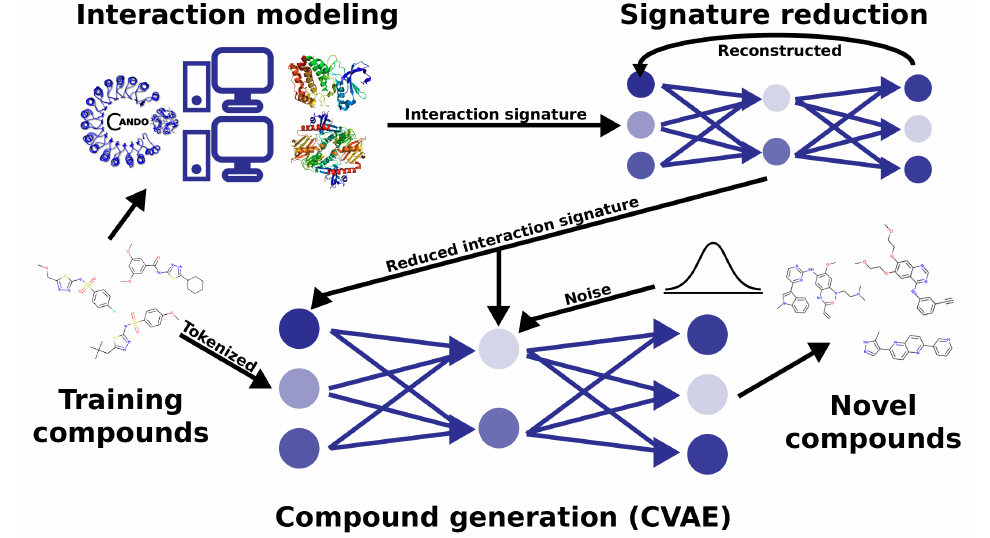
Figure 1. Deep -learning architecture and pipeline for generative drug design. We used the CANDO platform to predict interaction signatures for each compound in a training set against a library of nonredundant protein structures representing the human proteome. The interaction signatures have their dimensionality reduced in an autoencoder, which models the underlying correspondence between protein structures as they behave in the proteome. The reduced signatures are then used as labels for each training compound, which the generative conditional variational autoencoder model learns to reconstruct given a target interaction signature. This pipeline allows us to redesign behaviorally similar compounds to existing drugs based on their interaction signa- tures, as well as to modulate interactions on a proteomic scale as desired to generate behaviorally novel